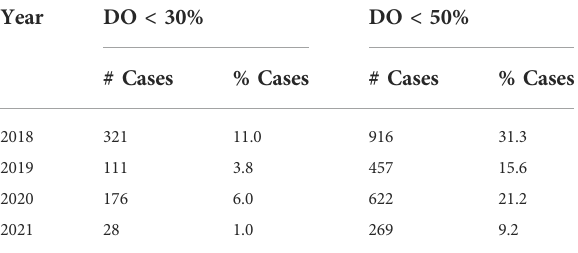
TABLE 1 Number of cases (and percentage) of hourly DO data below 30and50%ofsaturationvalue,recordedfromJunetoSeptember in the period 2018 – 2021. Data from SAMANET measuring